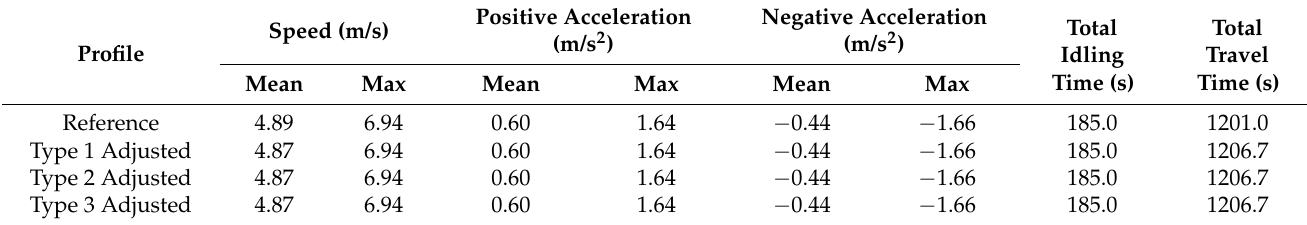
Table 3. Kinetic summary statistics of adjusted drive cycles (WMTC Cycle 1).